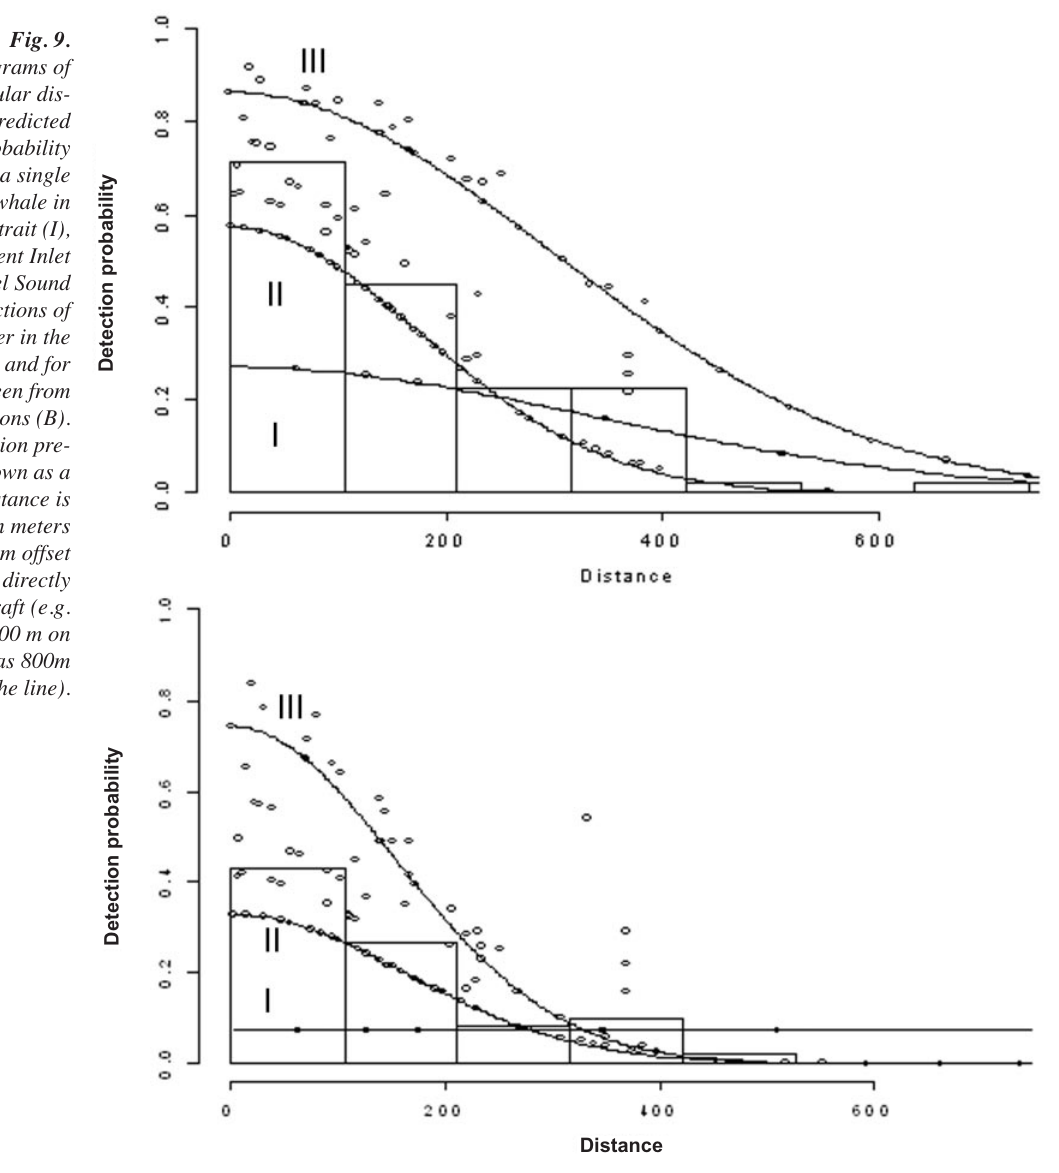
Fig. 9. Scaled histograms of perpendicular dis- tances and predicted detection probability functions for a